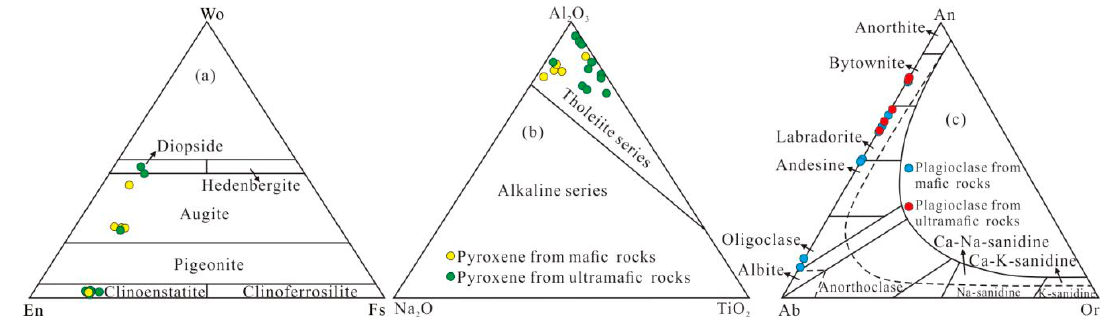
Figure 7. Wo-En-Fs diagram of pyroxenes ( a ) modified after Morimoto (1988) [27]); Al 2 O 3 -Na 2 O-TiO 2 diagram of pyroxenes ( b ) modified after Qiu and Liao (1996) [28]); Au-Ab-Or diagram of plagioclases ( c ) modified after Parsons (2010) [29]), in the Niubiziliang mafic-ultramafic complex.